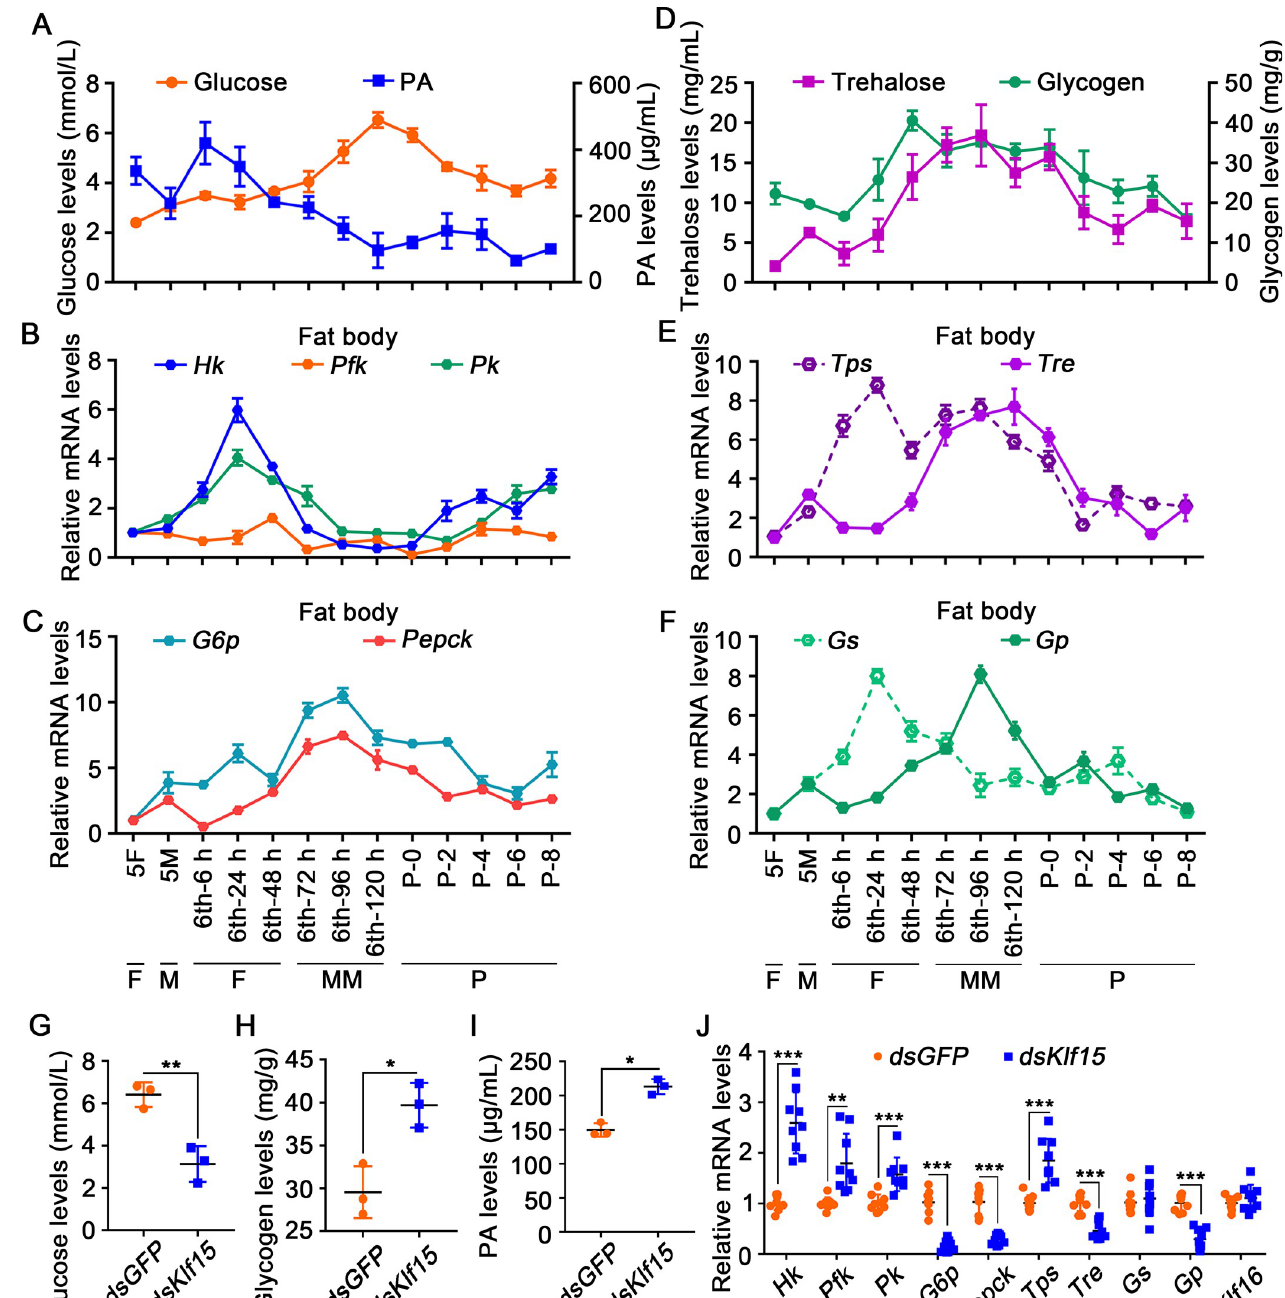
Fig 7. Variation in the levels of metabolites and related genes expression after Klf15 was knocked down in larvae. A. The levels of glucose and PA in the hemolymph. B. The expression profiles of Hk , Pfk , and Pk in the fat body. C. The expression profiles of G6p and Pepck in the fat body. D. Trehalose levels in the hemolymph and glycogen levels in the fat body. E. qRT-PCR showing the mRNA expression profiles of Tps and Tre in the fat body. F. The expression profiles of Gs and Gp in the fat body. G-I. Variation in the levels of metabolites after first injection dsKlf15 for 72 h. J. Changes in the expression levels of certain genes after Klf15 knockdown by injection of dsRNA, as detected using